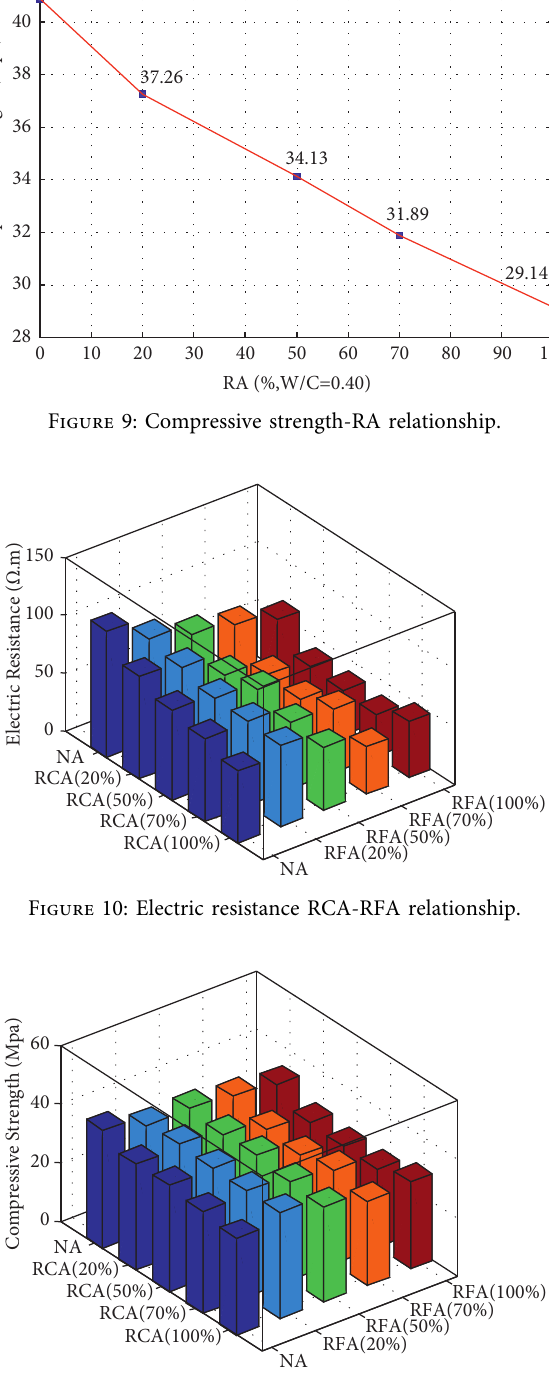
Figure 11: Compressive strength RCA-RFA